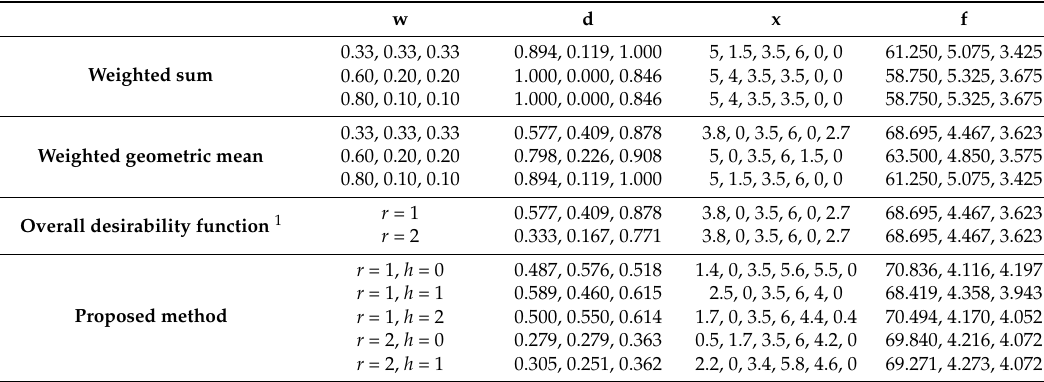
Table 8. Comparison with some weighting